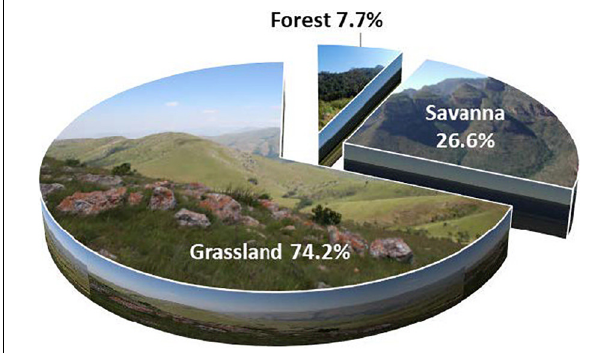
FIGURE 4 | Partitioning of endemic plant taxa per Biome (Grassland, Savanna, and Forest) in the Limpopo–Mpumalanga–Eswatini Escarpment